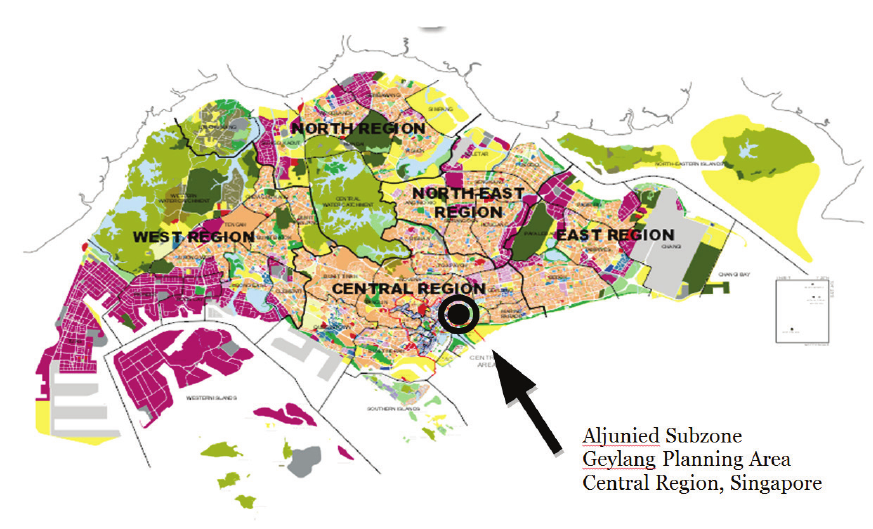
Figure 1. Location of Aljunied Subzone, Geylang, Singapore